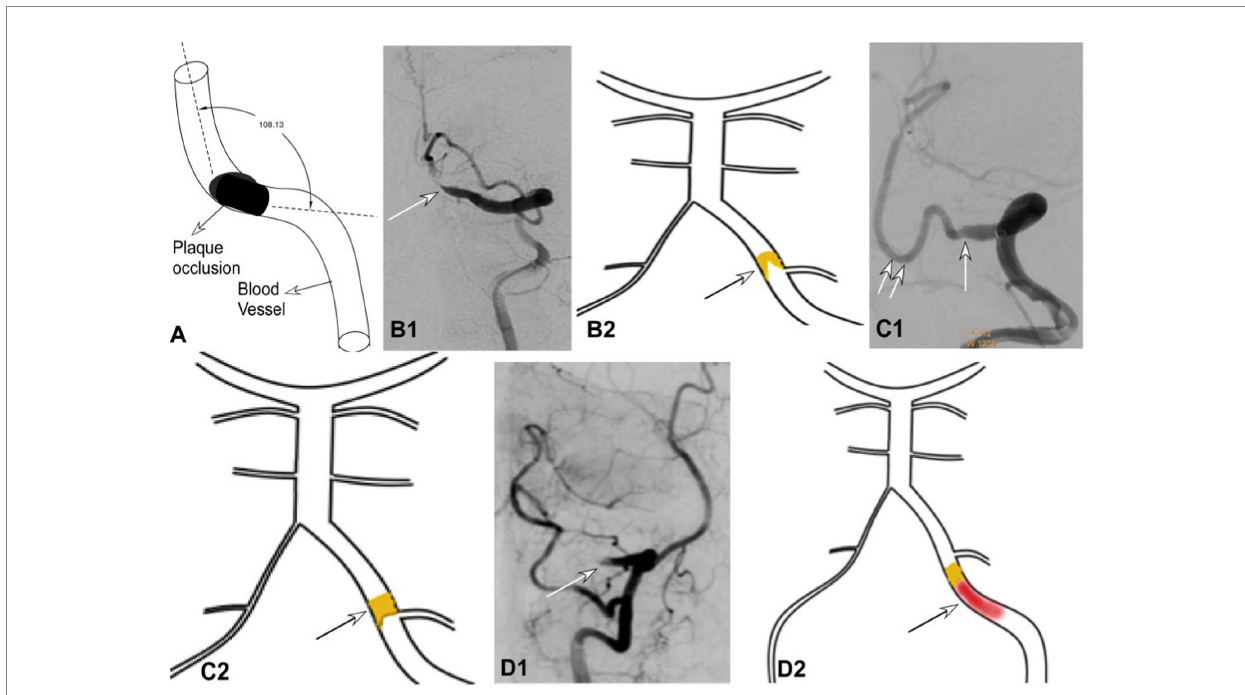
FIGURE 2 Occlusion angles and types of occlusion shape. (A) The arterial angle formed between the proximal and distal segments at the occlusion was measured. (B–D) Types of occlusion shape were defined, with the sharp occlusion in B1 , B2 (arrow), blunt occlusion in C1 , C2 (longer arrow), and flame-like occlusion in D1, D2 (arrow). The double arrows in C indicate the posterior inferior cerebellar artery. ( B1 , B2 ) The sharp occlusion shape in the major blood-supplying vertebral artery was shown in cerebral angiography in B1 and in the sketch in B2 . ( C1 , C2 ) The blunt occlusion in the major blood-supplying vertebral artery was shown in cerebral angiography in C1 and in the sketch in C2 . ( D1 , D2 ) The flame-like occlusion in the major blood-supplying vertebral artery was shown in cerebral angiography in D1 and in the sketch in D2